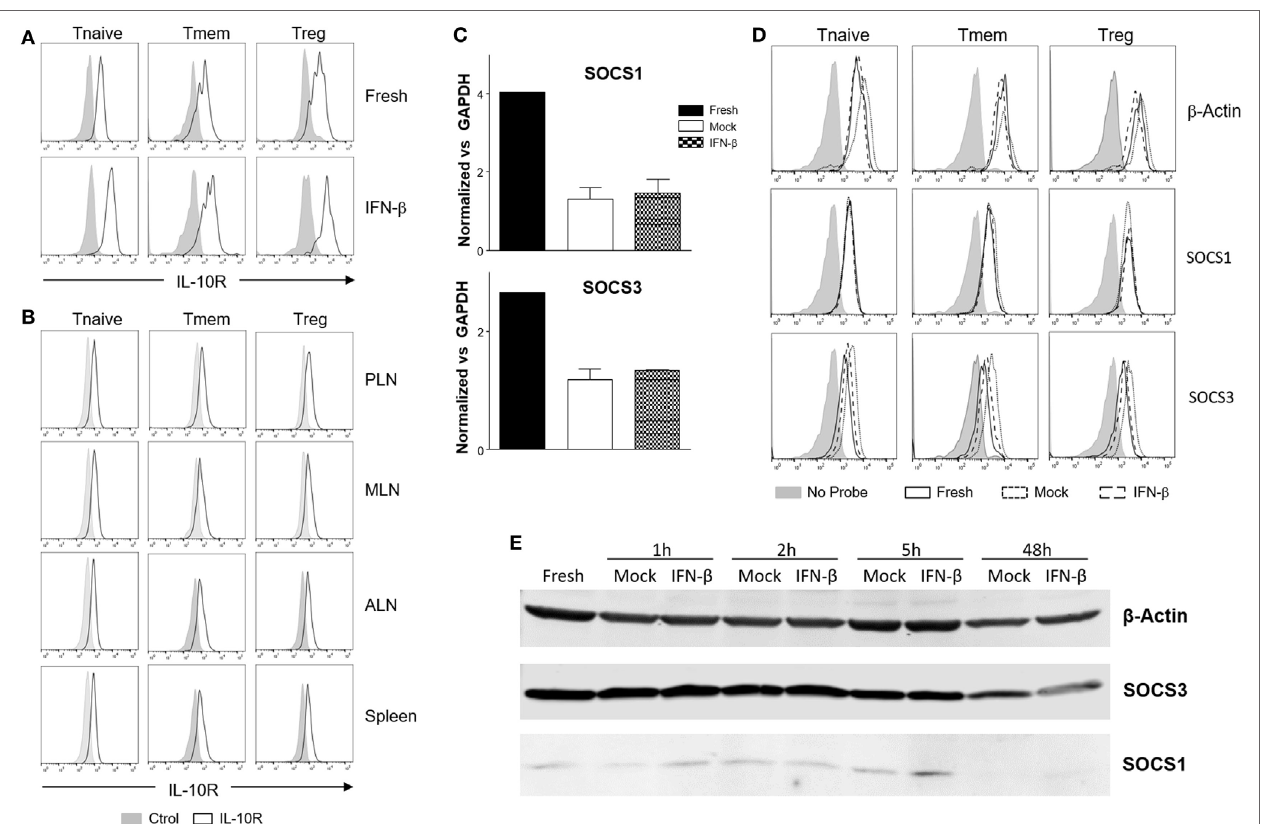
FigUre 6 | Alteration of surface interleukin-10 (IL-10)R expression or induction of suppressor of cytokine signaling protein (SOCS) molecules are not responsible for the inhibition of IL-10 signaling induced by IFN- β . (a,B) T cells from C57BL/6 mice (freshly isolated or post in vitro exposure to IFN- β ) (a) or total cells from pancreatic lymph nodes (PLN), mesentheric lymph nodes (MLN), axillary lymph nodes (ALN), and spleen of 4-week-old nonobese diabetic (NOD) mice (B) were stained for their expression of IL-10R in the indicated CD4 T cell subpopulation by flow cytometry. (c–e) Purified CD4 memory T cells (Tmem) (obtained via